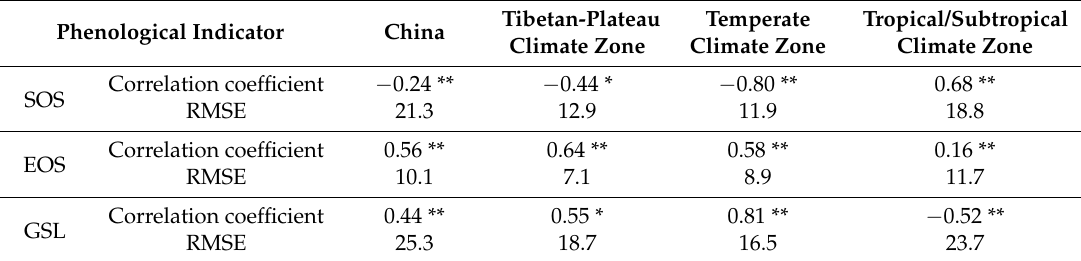
Table 3. Relationship between LST and phenology in urban and rural